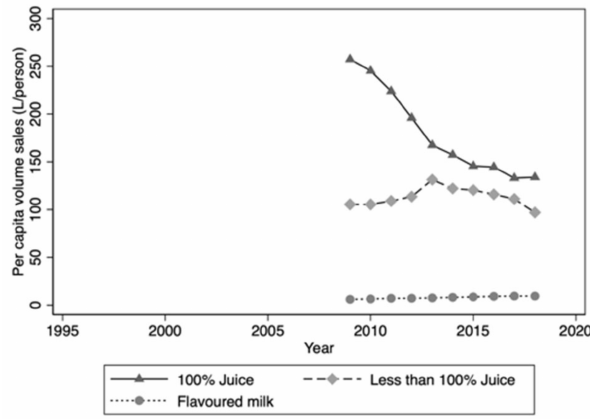
Figure 3. Per capita volume sales: Juice/juice drinks and flavoured milk drinks 2009–2018. The correct data were provided by IRI Australia. Please replace the above figure with this one below.